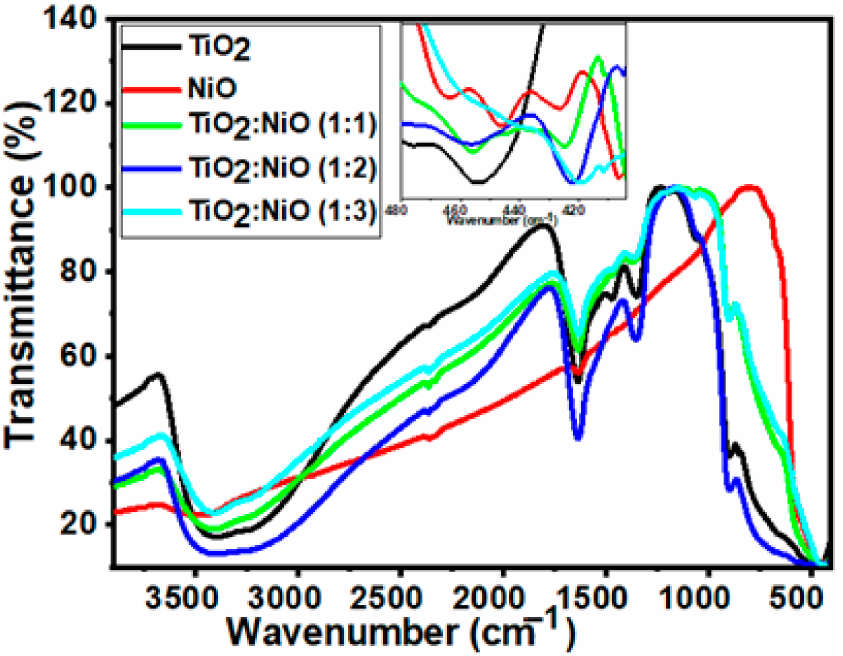
Figure 5. FTIR spectra of TiO 2 NTs, NiO NPs, and TiO 2 /xNiO nanocomposite. Two bands located between 2366 and 2338 cm − 1 for pure TiO 2 NTs are assigned to C-H stretching vibrations. These bands are shifted to 2365 and 2342 cm − 1 for TiO 2 /3NiO, respectively. The peak at ~1635 cm − 1 refers to the bending modes of Ti-OH [68]. This